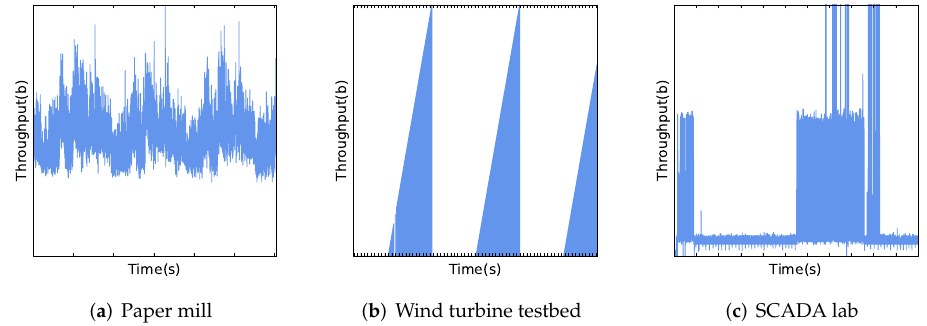
Figure 1. The complexity of the communication patterns from three different sources is visualized. Even in smaller time intervals, the aggregated traffic of the production line is more complex, while also showing the operational